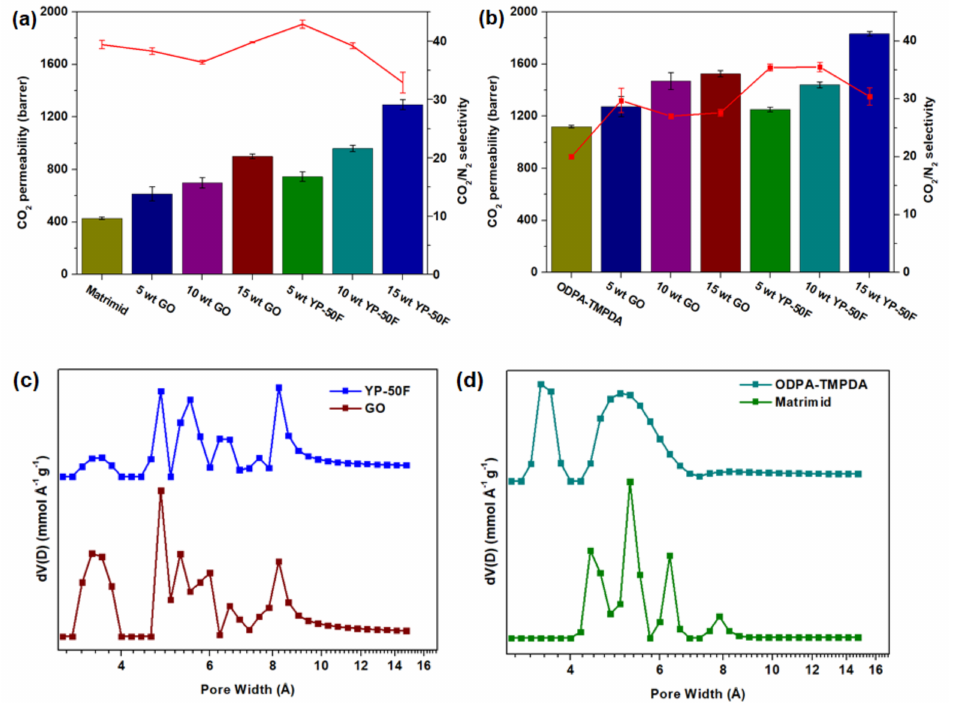
Figure 8. Gas permeation properties of GO- and YP-50F-based mixed-matrix CMSMs for CO 2 /N 2 separation. The bar graphs indicate CO 2 permeability, whereas the line graphs indicate CO 2 /N 2 selec- tivity. ( a ) shows the results for membranes with Matrimid ® 5218 as the polymer precursor, whereas ( b ) shows the results for membranes with ODPA-TMPDA as the polymer precursor; ( c ) micropore size distribution of YP-50F and GO; ( d ) micropore size distribution of CMSMs (ODPA-TMPDA and Matrimid ®